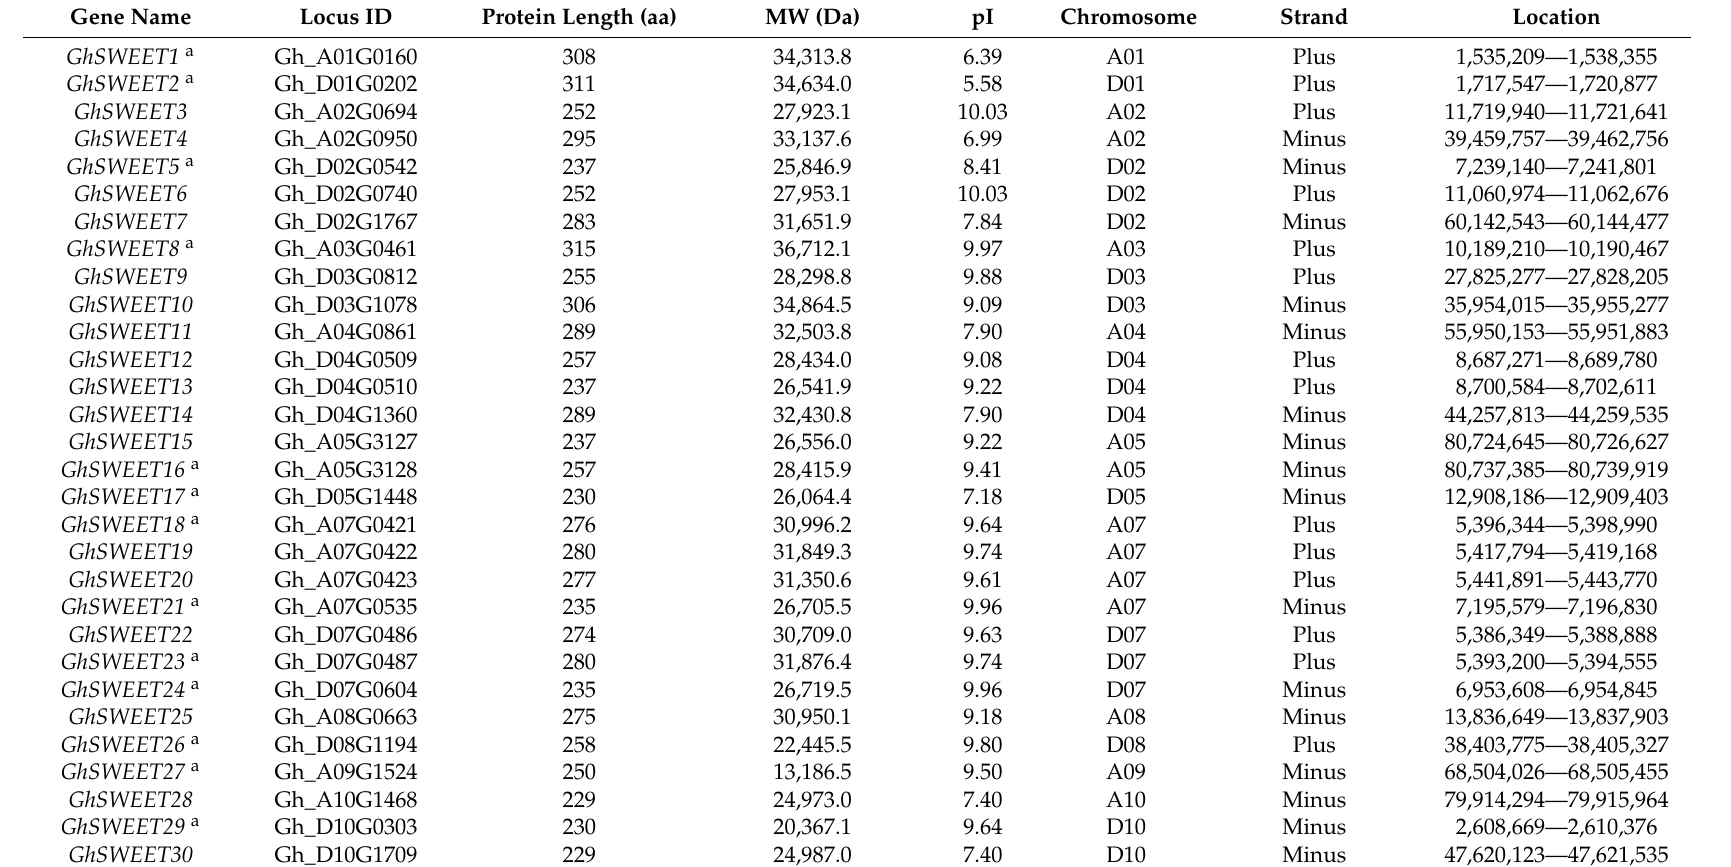
Table 1. Characteristics of the G. hirsutum SWEET